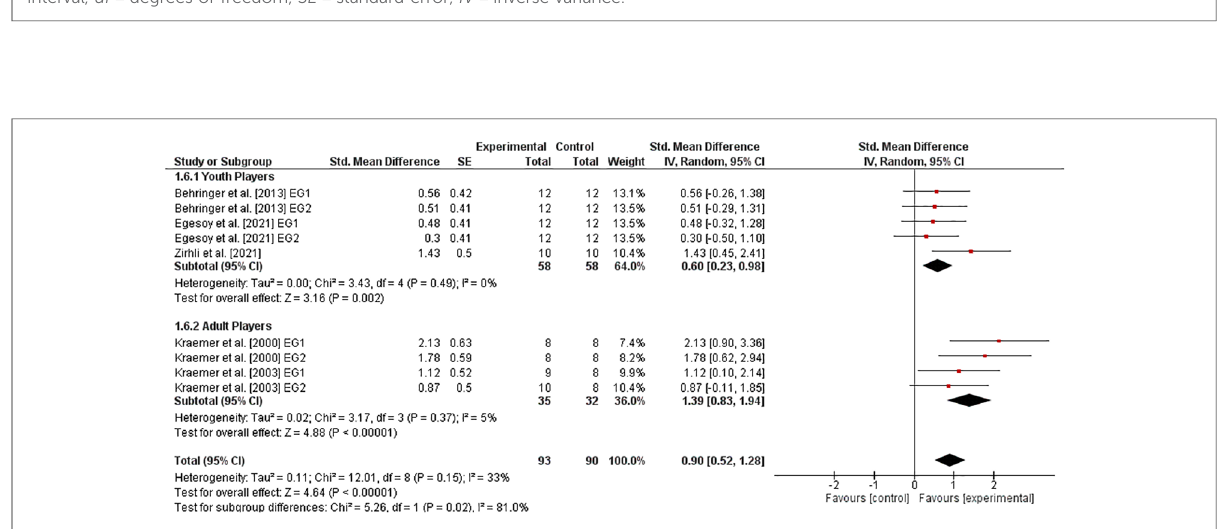
FIGURE 5 Effects of athletic training on measures of upper-extremity muscle power (e.g., medicine ball throw) in healthy youth tennis players. CI =con fi dence interval, df =degrees of freedom, SE =standard error, IV =inverse variance.